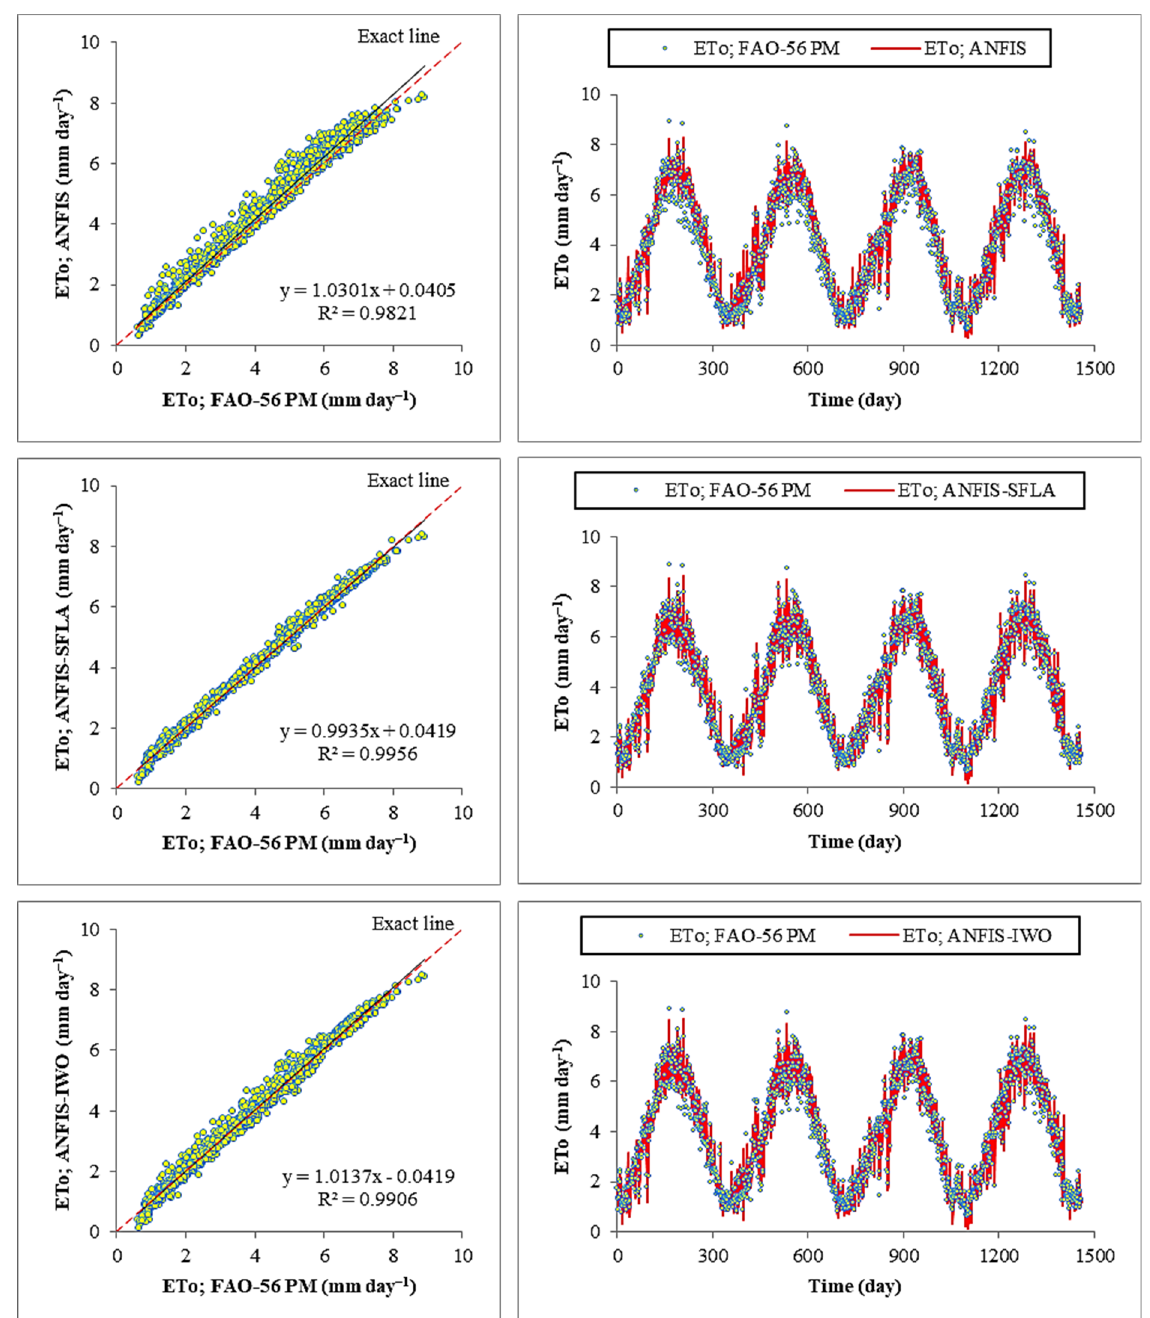
Figure 6. Scatter and time series plots of the daily values of FAO-56 PM ETo vs. modeled data by the best hybrid models and the corresponding classical model (i.e., M7 models) during the test phase (Shiraz station).